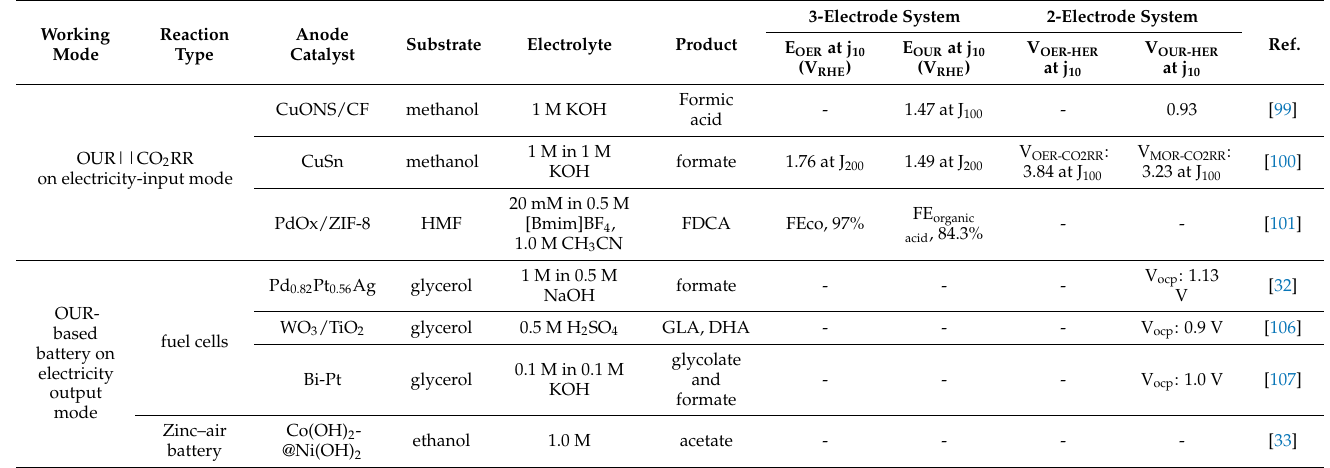
Table 2. Electrocatalytic performance of recently reported representative OUR electrocatalysts, the OUR||CO 2 RR systems and OUR-based devices (fuel cell and zinc–air